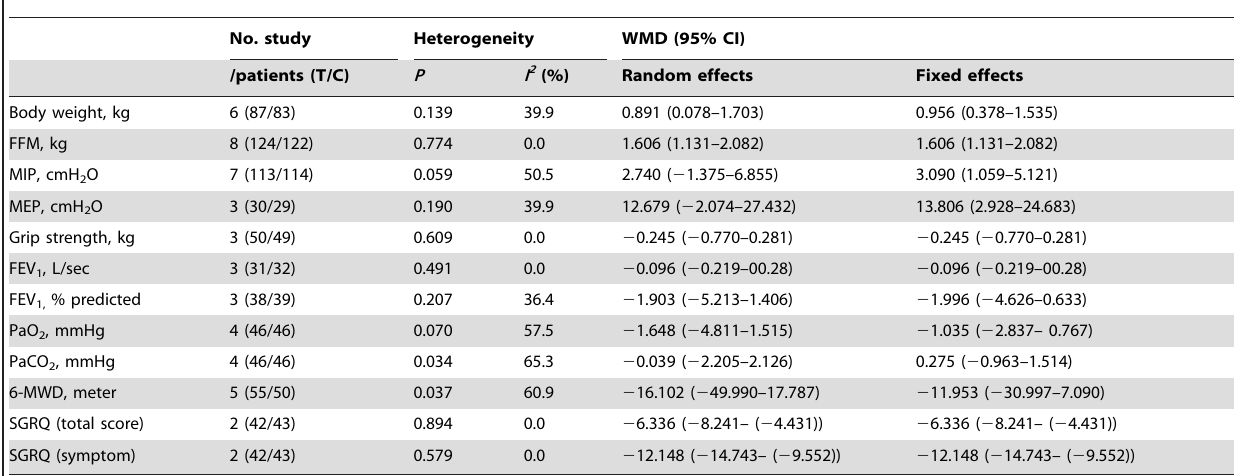
Table 4. The results of pooled analyses.